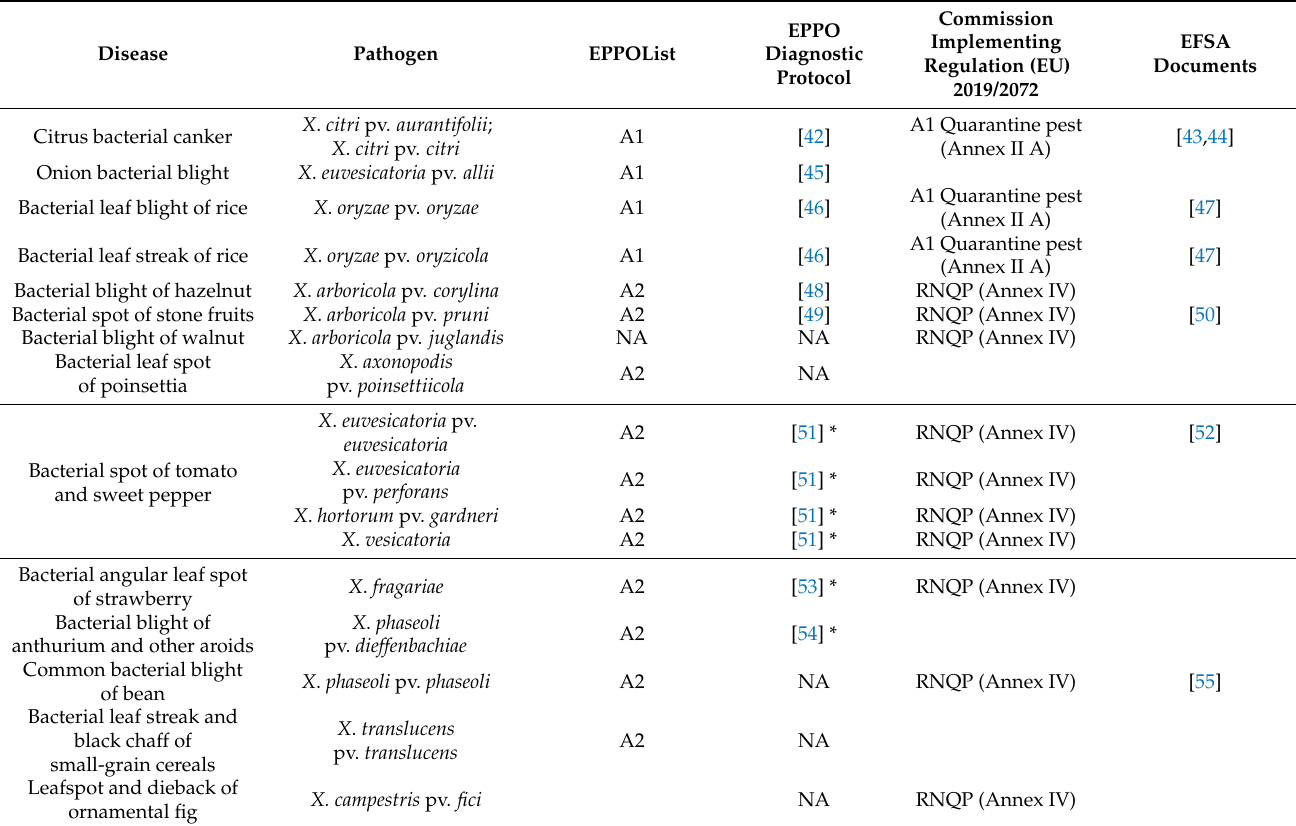
Table 1. Diseases, their regulation and recommendations for